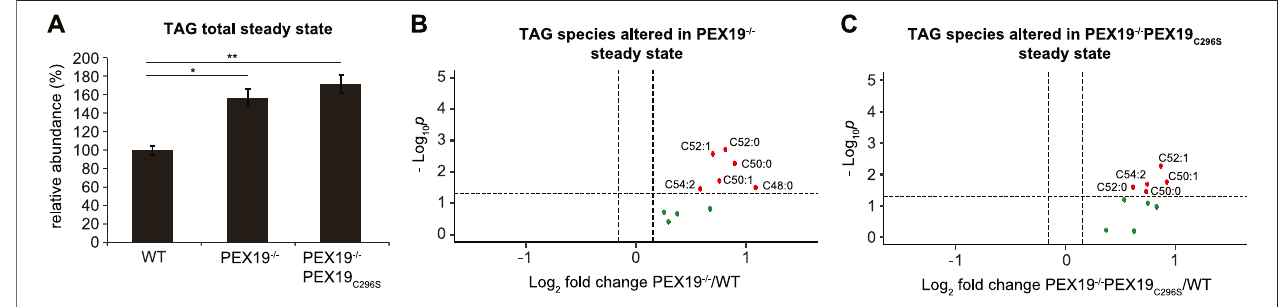
FIGURE 3 | Triacylglycerols accumulate in PEX19-compromised cells. Shotgun-lipidomics results for TAG species. (A) Bar diagram showing the relative abundance of total TAG species in WT, PEX19 − / − and PEX19 − / − PEX19 C296S cells. Error bars indicate SEM and statistical signi fi cance between the groups was determined by an ANOVA followed by Tukey post-hoc test. *,** indicate p -values < 0.05 and < 0.01, respectively. Non-signi fi cant changes are not indicated. (B,C) Volcano plots of TAG subspecies analyses. 10 TAG species were analyzed and logarithmically plotted against the p -value (derived from unpaired, two-sided Student ’ s t-test) after FDR-correction, illustrating changes in PEX19 − / − cells (B) and PEX19 − / − PEX19 C296S cells (C) compared to WT cells, respectively. Grey dots: lipid species without signi fi cant changes. Green dots: lipid species with a fold change greater than the average SEM but with a p -value > 0.05. Red dots: signi fi cantly altered ( p -value <